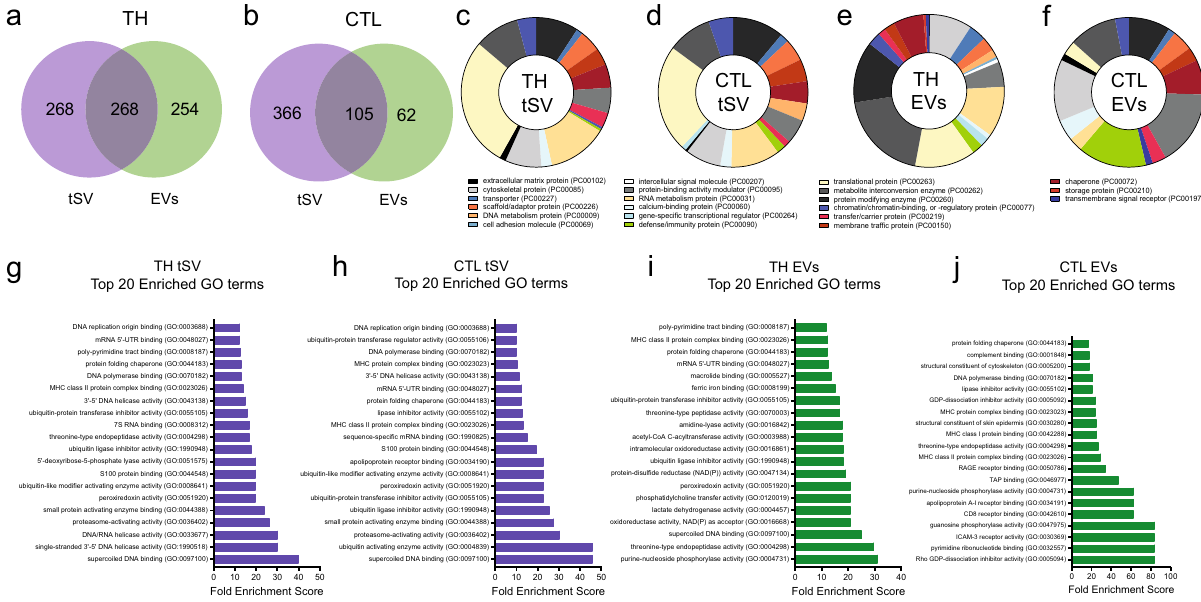
Fig. 6 tSV are enriched in proteins related to ubiquitination and RNA-binding proteins. a – b Venn-diagrams showing the overlap of enriched proteins identi fi ed in the tSV and EVs of TH ( a ) and CTL ( b ). c – f Pie charts showing the enriched protein classes identi fi ed with PANTHER 48 in the tSV of TH ( c ) and CTL ( d ), and in their syngeneic EV counterparts ( e – f ). g – j GSEA using PANTHER 86 revealed a greater enrichment of molecular function categories related to nucleic acid-binding and ubiquitination in the proteomics of tSV derived from TH ( g ) and CTL ( h ) as compared with syngeneic EVs of TH ( i ) and CTLs ( j ). Data from n = 4 biologically independent samples (donors, a – j ) across four independent experiments. Statistical analysis for functional and biological pathway enrichment analyses ( c – f ) using PANTHER was performed by the Fisher ’ s exact test and the Benjamini – Hochberg False Discovery Rate (FDR) correction using default Q values. In g – j , the result of GO enrichment analyses were fi ltered using Funset with the Benjamini-Hochberg correction (FDR threshold to 0.05) on P values determined by the hypergeometric